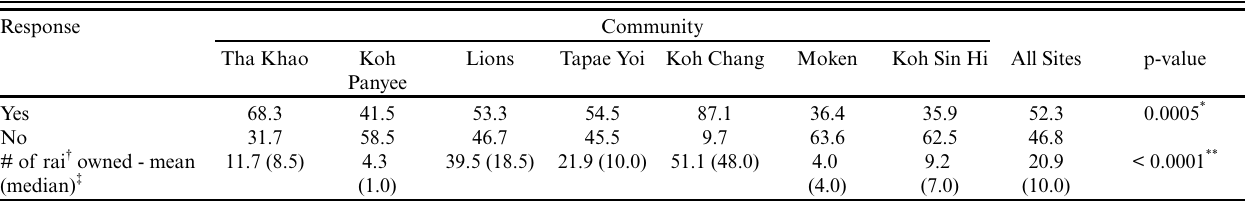
Table 5 . Do people in your household own land suitable for agriculture or tourism livelihoods (% of households).